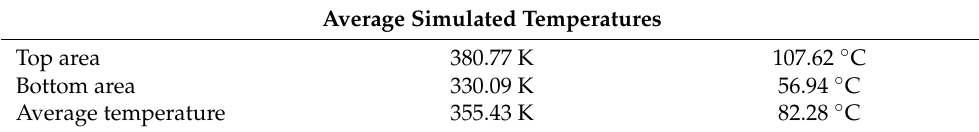
Table 9. Average simulated temperatures in two areas in the